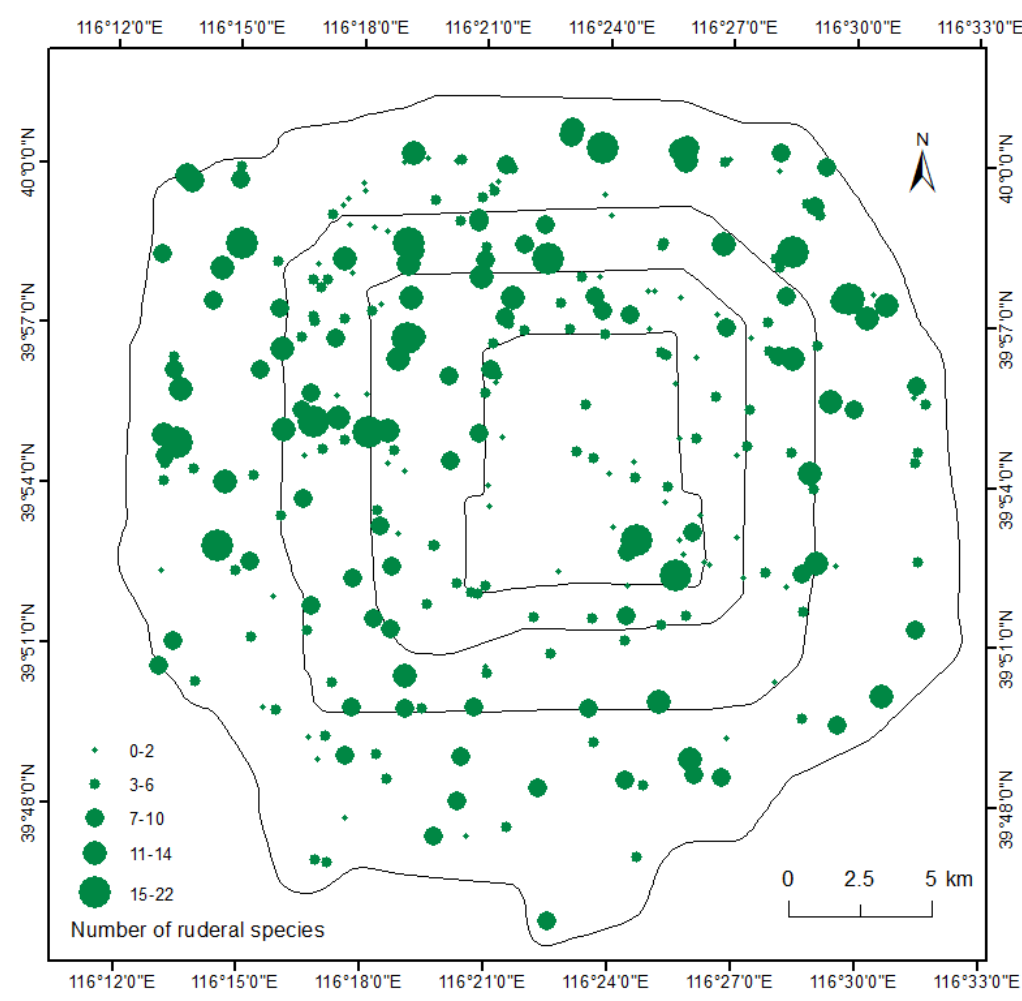
Figure 1. Number of ruderal species in the built-up areas of Beijing.